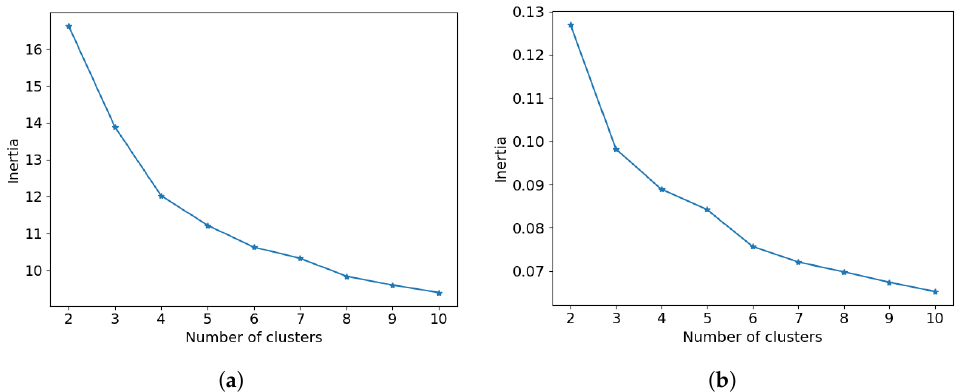
Figure 11. Determining the optimal number of clusters using the Elbow method for both use-case scenarios, namely ( a ) flooding and ( b )